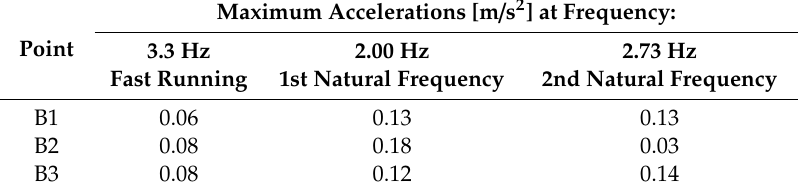
Table 14. Maximum vertical accelerations generated by a single pedestrian running obtained at the representative points of the beam footbridge with the GFRP slab for the selected frequencies. Point Maximum Accelerations [m/s 2 ] at Frequency: 3.3 Hz Fast Running